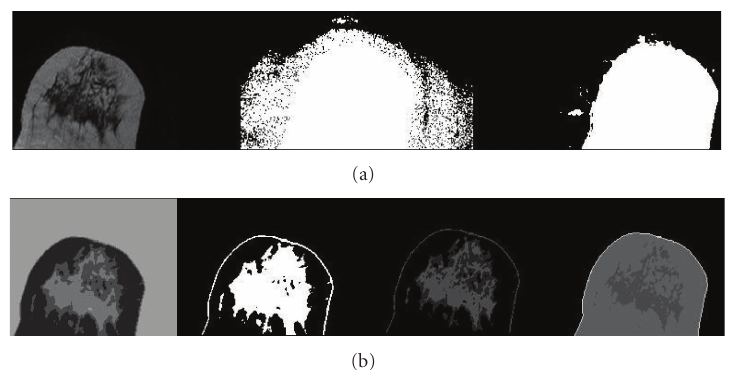
Figure 3: From left to right (a): original MRI slice; pixels with gray value higher than 0; pixels with gray value higher than 0 after curvature flow filter and low threshold. From left to right (b): C -means with 4 clusters; clusters with skin and dense tissue; new C -means with 2 clusters; final skin classification (white pixel values).